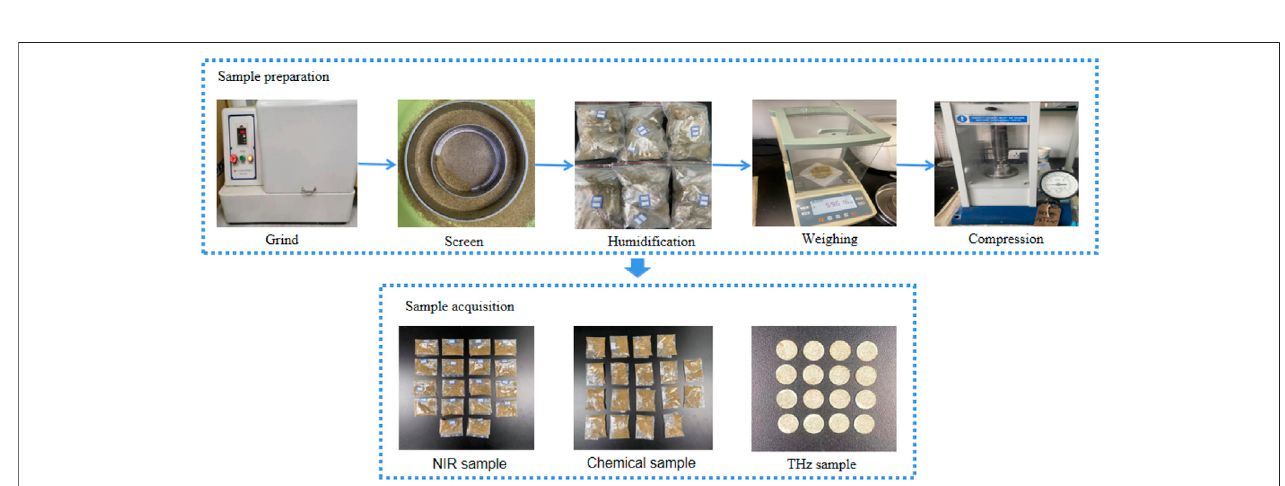
FIGURE 2 | Sample